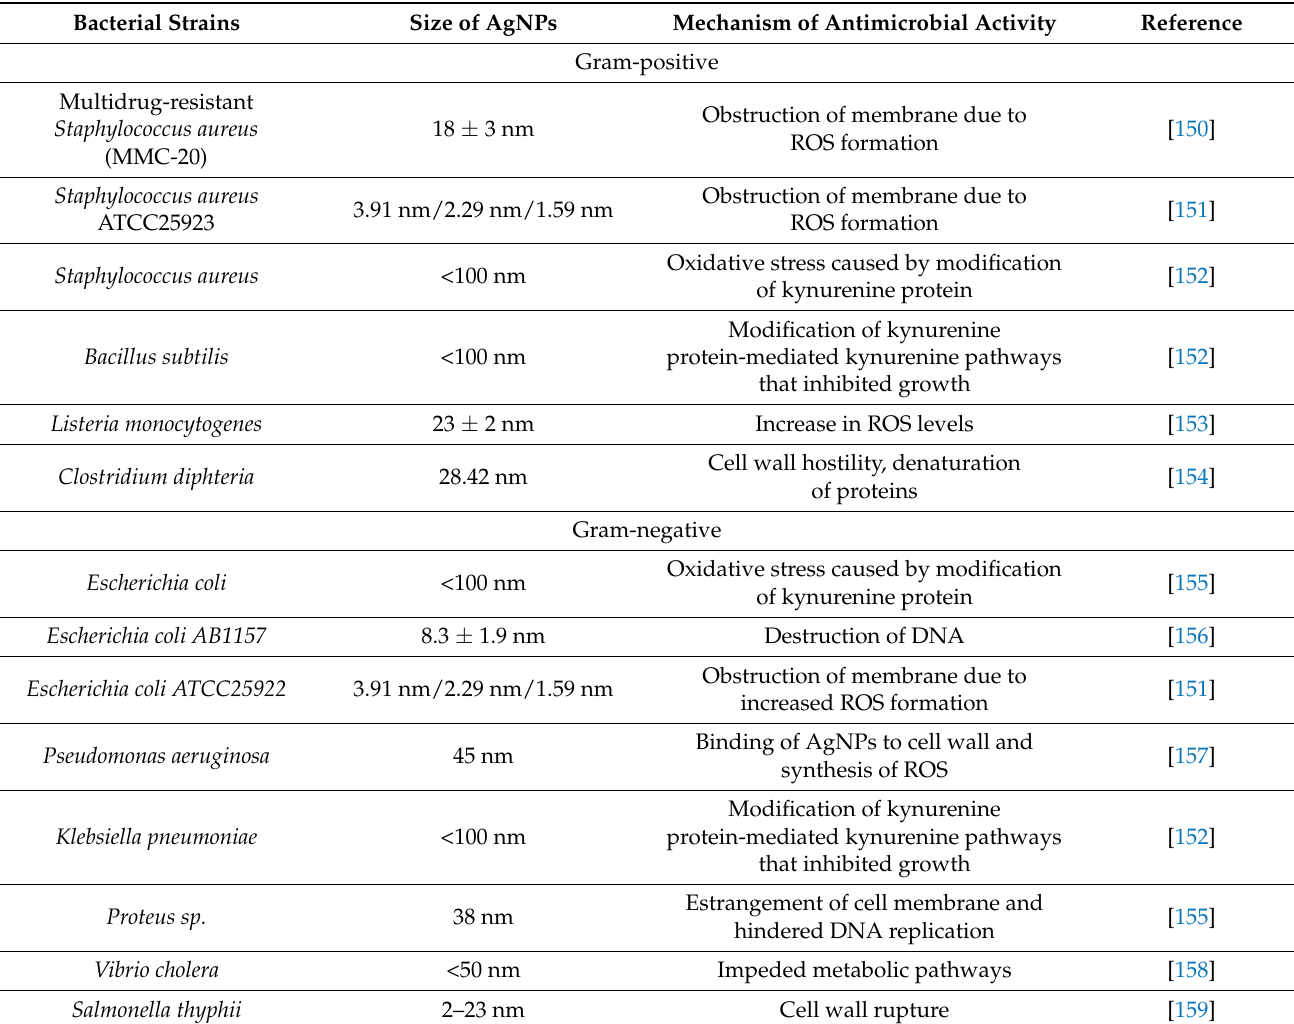
Table 4. The antimicrobial activities of AgNPs